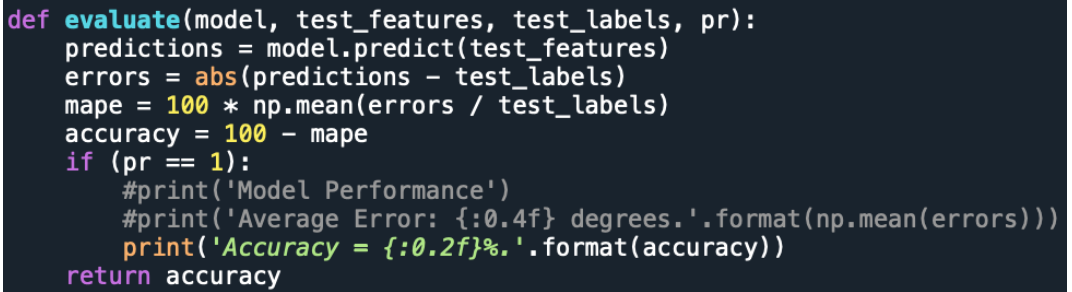
Figure A7. Python code excerpt for implementing random forest evaluation method.